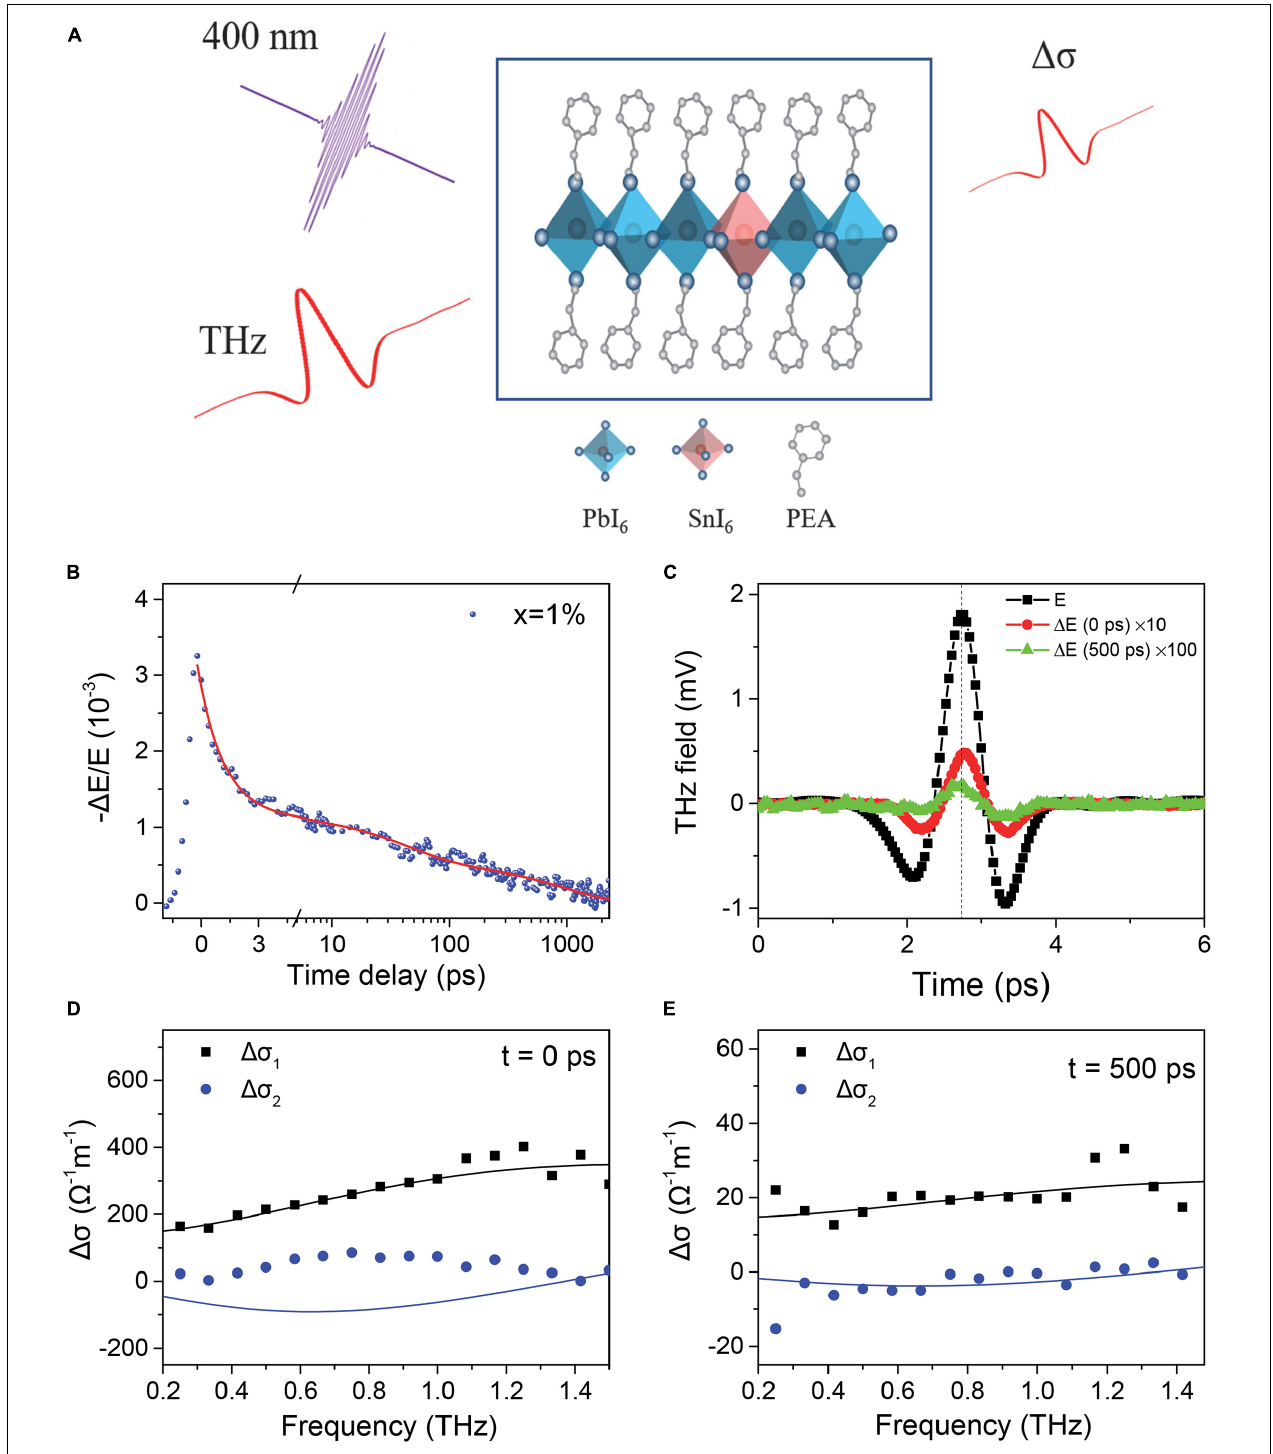
FIGURE 1 | (A) Schematic of OPTP measurements in Sn-doped 2D perovskites. The dynamics of charge carriers is probed by measuring photo-induced photoconductivity change ( (cid:49) σ ) in the THz spectral domain. (B) The time-dependent trace of THz transmission change ( − (cid:49) E/E) recorded from a 2D perovskite sample of PEA 2 Sn x Pb 1 − x I 4 ( x = 1%) with pump at 400 nm of 10 µ J/cm 2 (excitation density of ∼ 8 × 10 17 cm − 3 ) The decay trace can be reproduced by a function with three exponentially decay components. (C) The photo-excited change of THz waveform at the time delays of 0 and 500 ps is compared with the probe THz spectrum, respectively. The calculated spectra of complex (cid:49) σ at the delays of 0 (D) and 500 ps (E) are compared with the fitting curves through the Drude-Smith model.